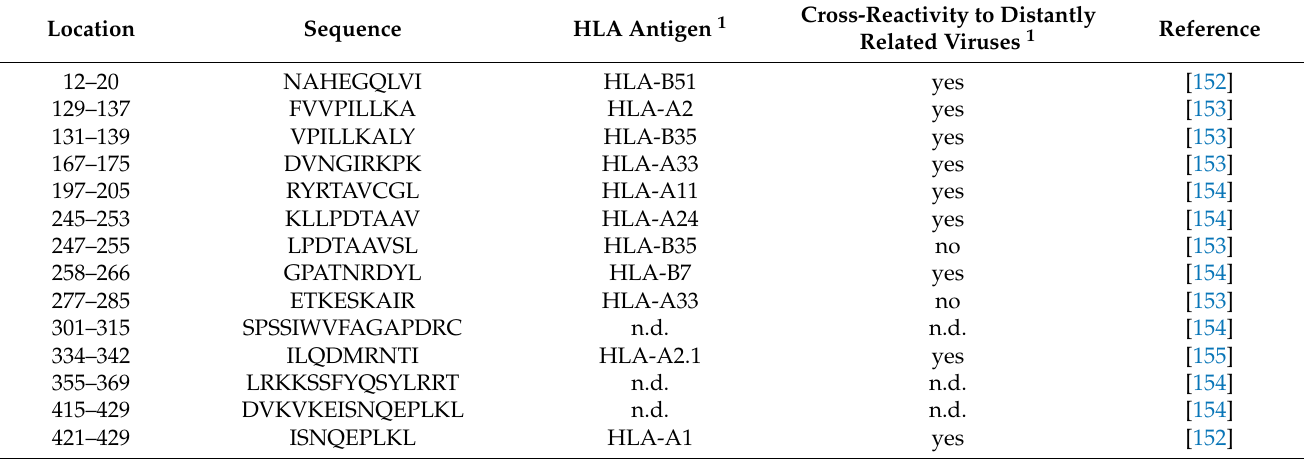
Table 2. Cytotoxic T-cell epitopes of the Hantaan